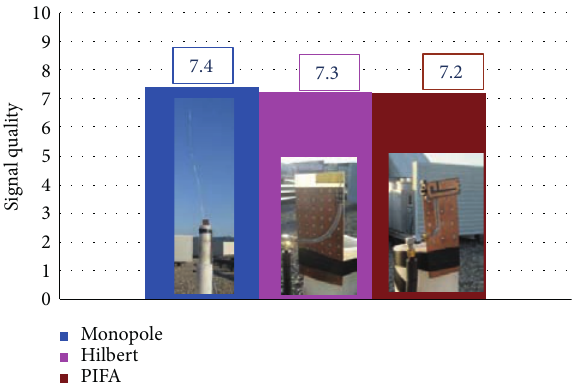
F 12: Marks obtained through the quality evaluation aer averaging 28 FM channels.